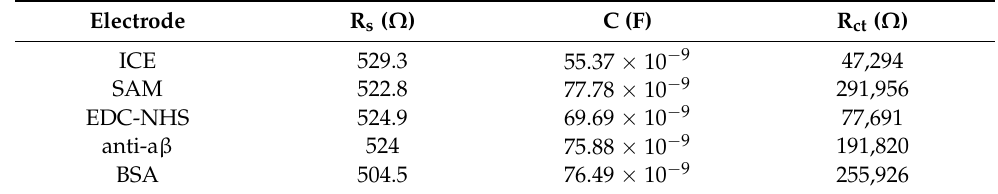
Table 1. EIS parameters of the bare and modified ICE extrapolated by fitting the measured spectra to the equivalent circuit model shown in Figure 3a.